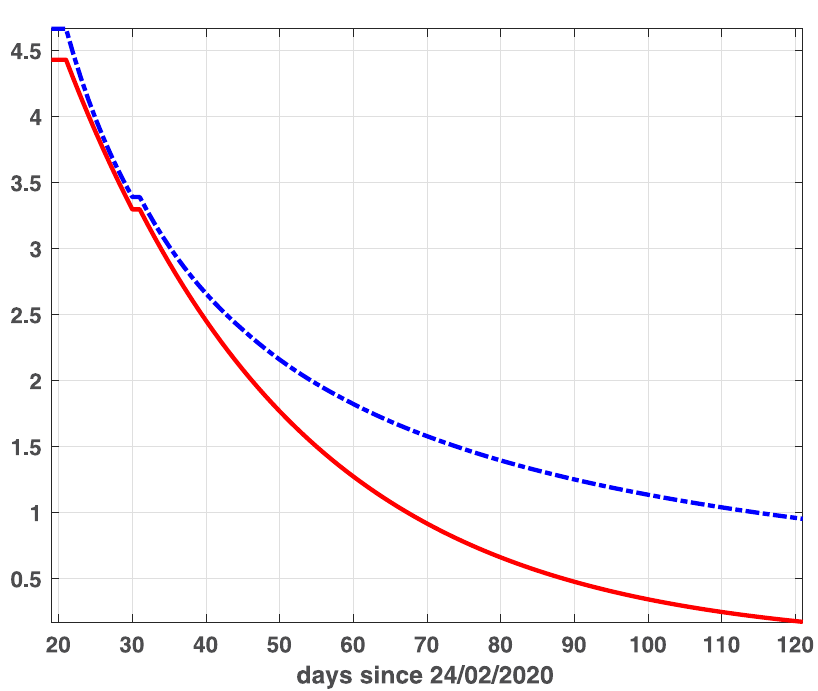
Fig 13. Reproduction function in Emilia-Romagna. R ð t Þ predicted until 24/06/2020 after the calibration of fSEIRDe (red continuous line) and fSEIDRr (blue dash-dotted line) on the data in the period [24/02-27/03].